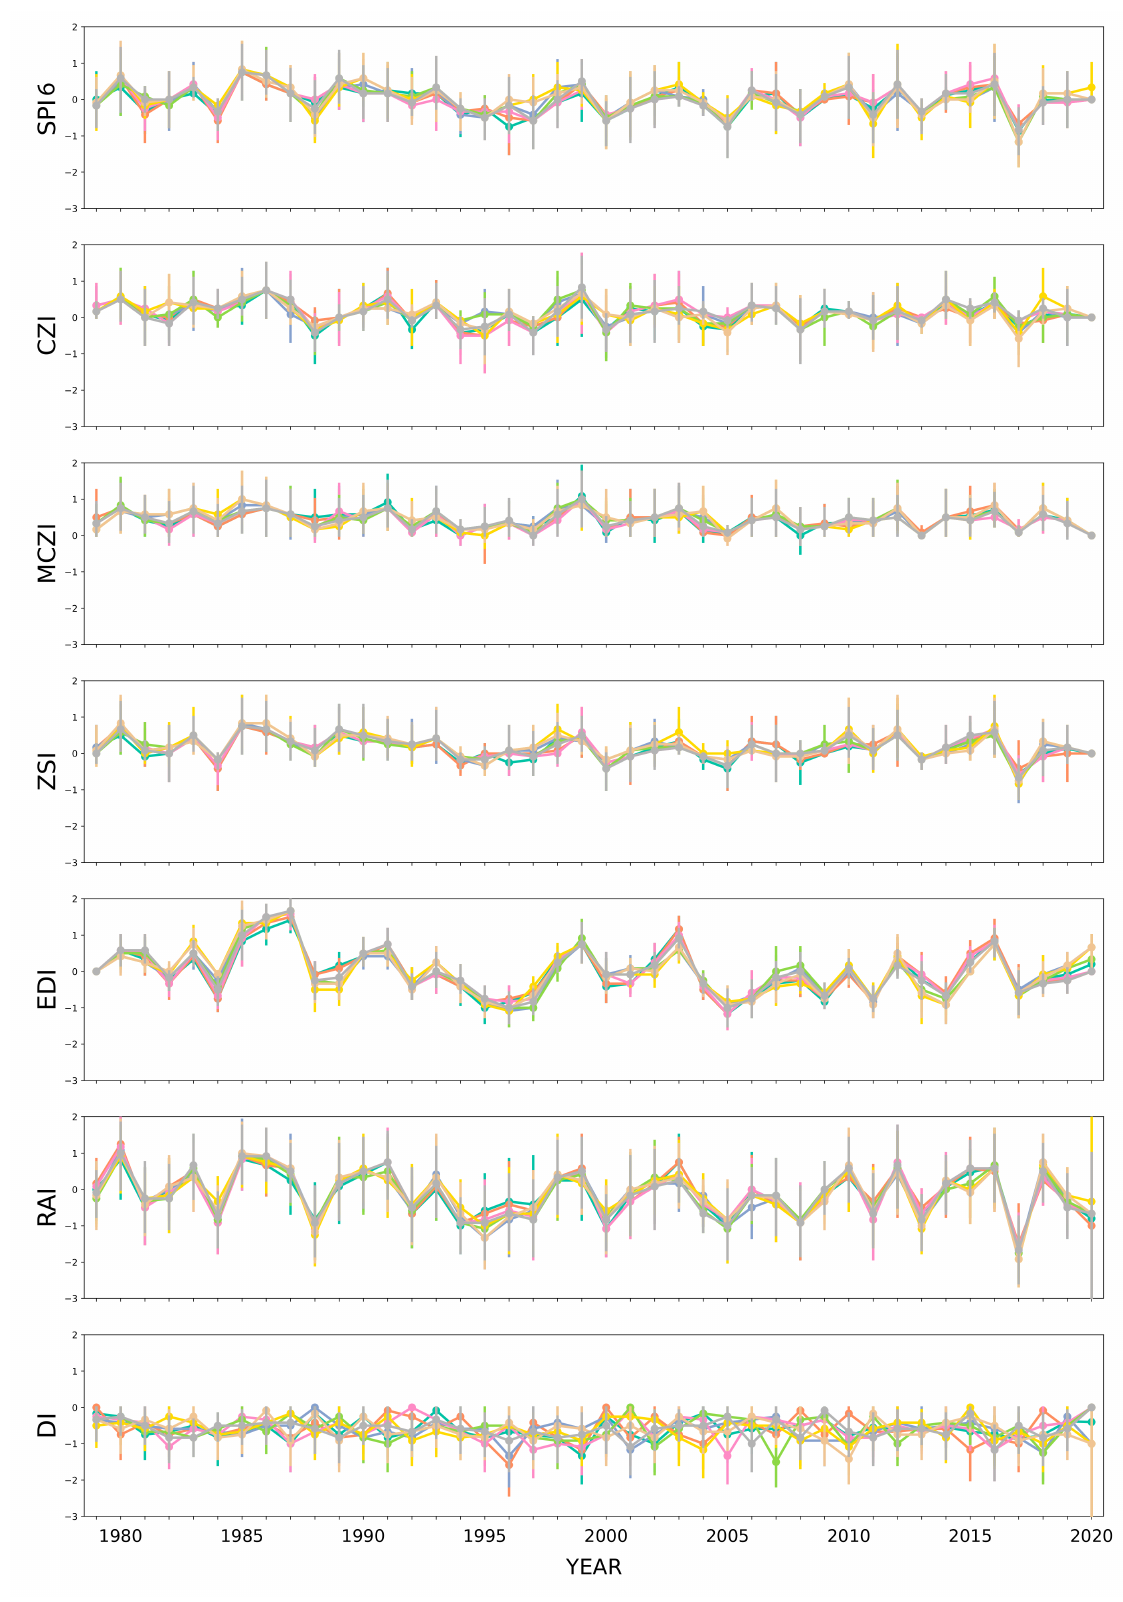
Figure A1. Seven drought indices calculated using ERA5 data for each vegetation type in South Korea